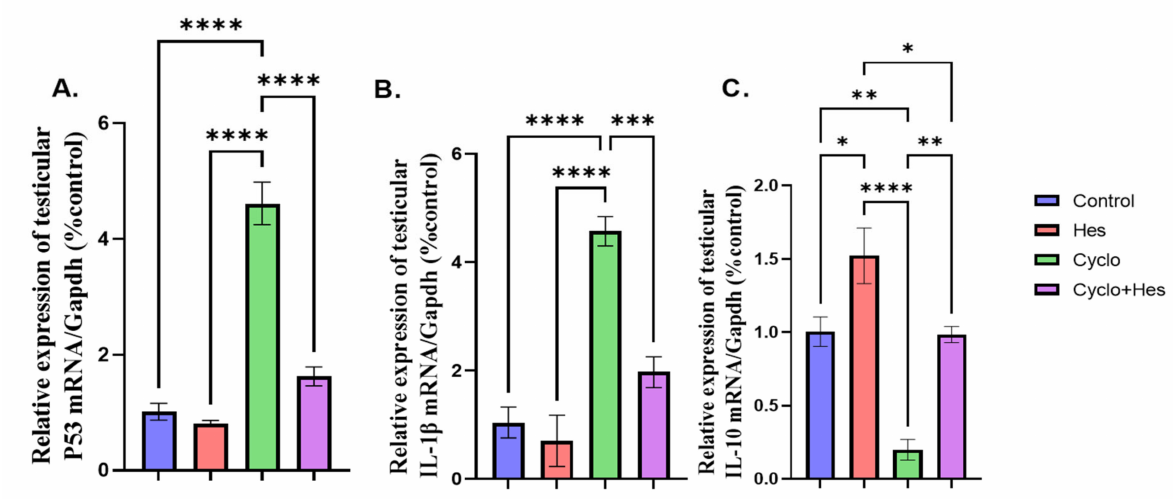
Figure 7. Effect of hesperidin administration in cyclophosphamide-induced testicular impairment in male rats on mRNA expression of testicular P53, IL1B, and IL10 ( A – C ). ( A ) Testicular P53/Gapdh (% control), ( B ) mRNA expression of testicular IL1B/Gapdh (% control), and ( C ) mRNA expression of testicular IL10/Gapdh (% control). Data are expressed as means ± SEM. *, **, ***, **** indicate significant difference ( p <